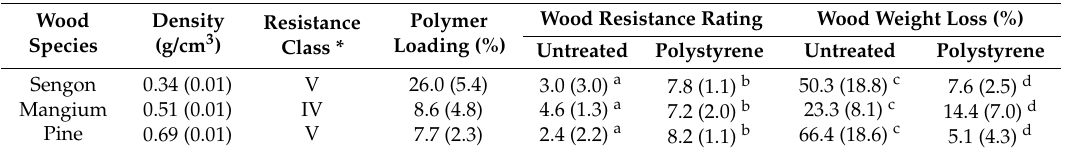
Table 2. Density and resistance class of untreated woods and the polymer loading, wood resistance rating, and wood weight loss of untreated and polystyrene wood samples.